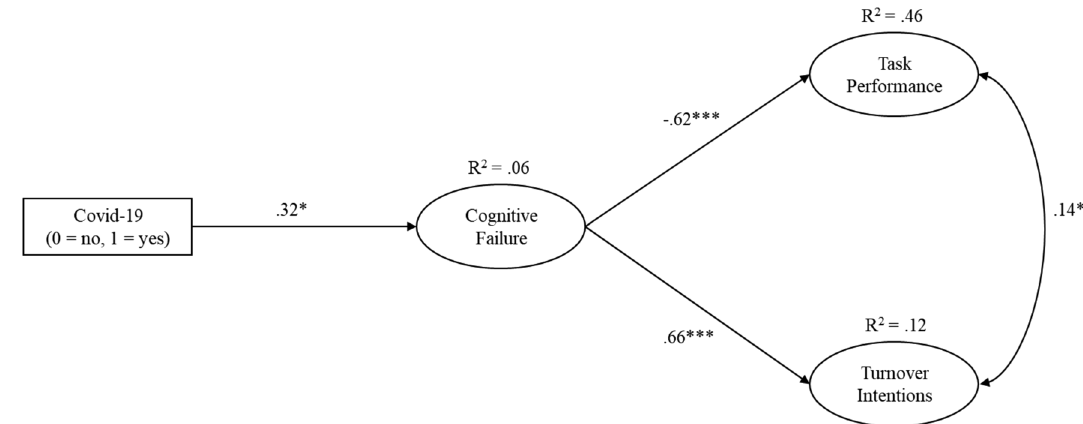
Figure 1. Structural model demonstrating the indirect effect of having contracted Covid-19 on task performance and turnover intentions via cognitive failure. *p < .05, ***p <